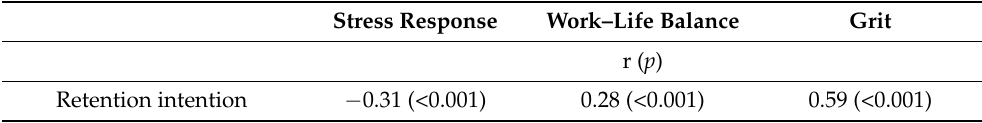
Table 2. Correlation between retention intention and